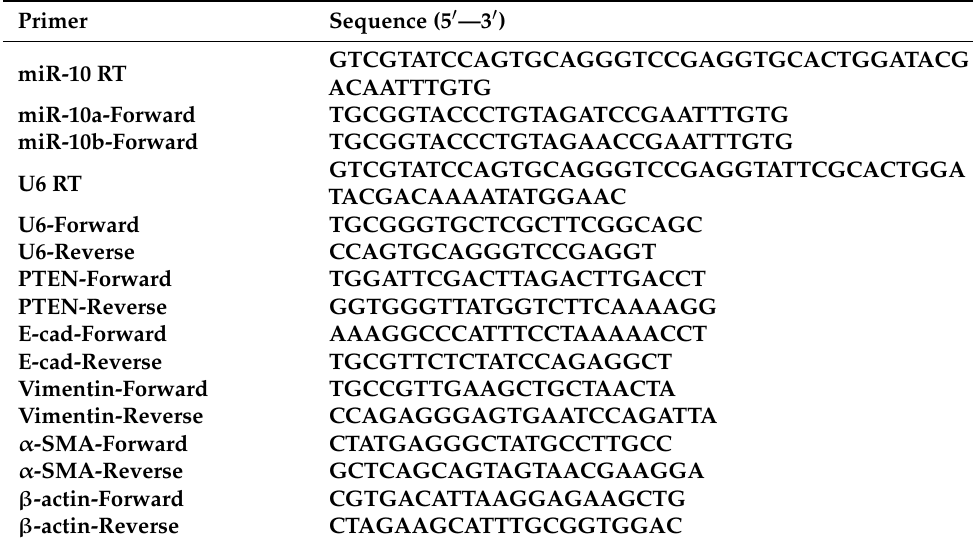
Table 2. Sequences of each